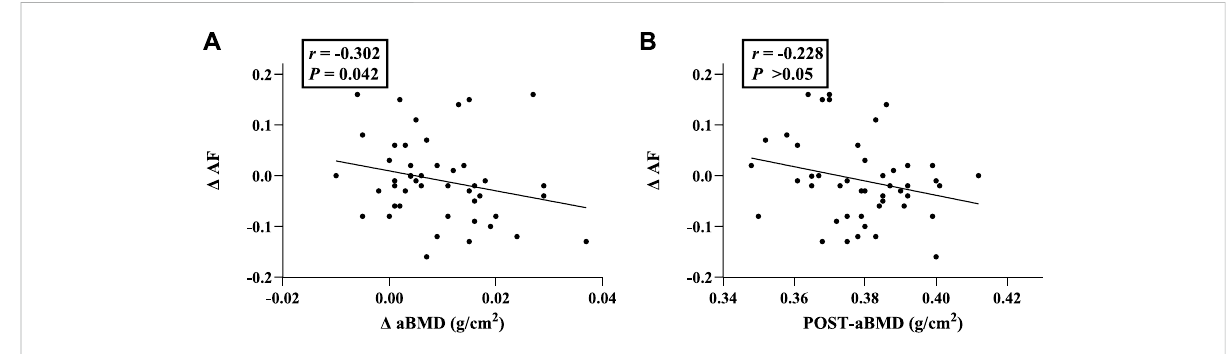
FIGURE 3 Correlation analysis between Δ AF and aBMD-related indicators. (A) Correlation of Δ AF with Δ aBMD; (B) Correlation of Δ AF with aBMD (Post- exercise). Abbreviations: aBMD, areal bone mineral density; AF, auto fl uorescence; Δ AF, change of AF value; Δ aBMD, change of aBMD.